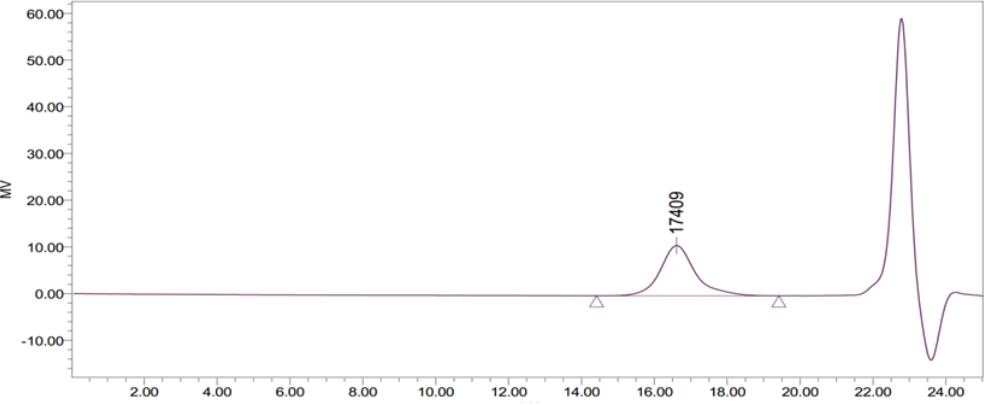
Figure 3. Gel permeation chromatogram of GO-ZnO-PLLA molecular weight. Table 1. Results of gel permeation chromatogram analysis of GO-ZnO-PLLA molecular weight.